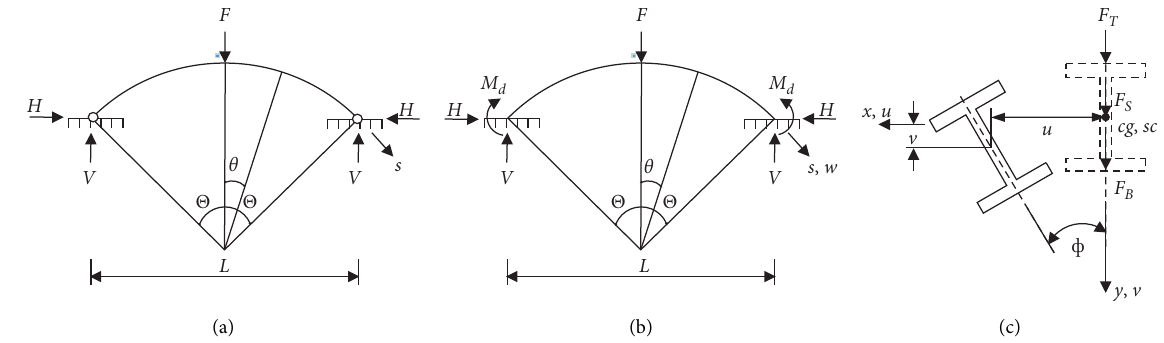
Figure 3: Reactions on pinned and fixed arches subjected to central concentrated load (redrawn from [58]). (a) Pinned arch. (b) Fixed arch. (c) Lateral-torsional buckling.